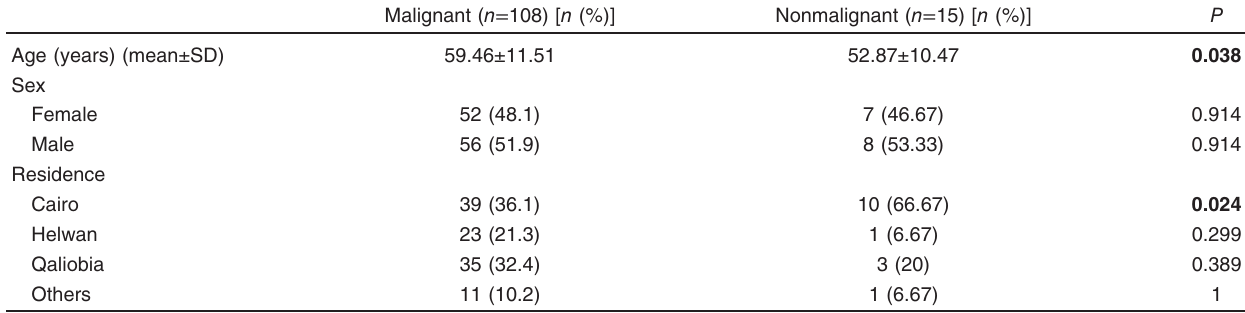
Table 2 Comparison between cases with malignant and non-malignant pleural effusion regarding the demographic data